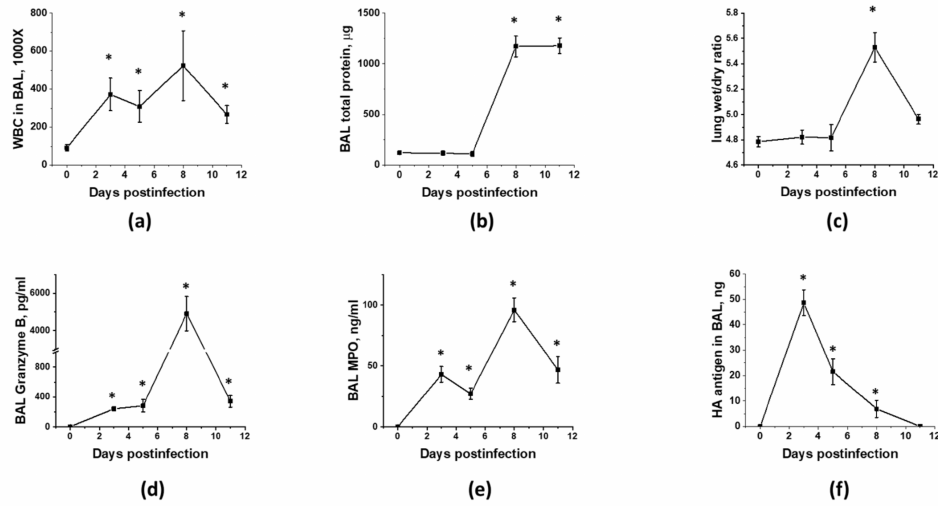
Figure 1. Murine lung infection with IAV is characterized by two distinct phases, a viral clearance phase and a lung injury phase, with white blood cell infiltration during former and latter phases. C57Bl/6 mice received intranasal administration of IAV H1N1 PR8 (800 pfu/mouse) on Day0. Lungs and BAL were collected on the days indicated to analyze for BAL total protein levels ( a ) and white blood cell count ( b ), lung wet/dry ratio ( c ), acellular BAL granzyme B ( d ) and MPO ( e ) levels, and PR8 hemagglutinin level ( f ). n = 4–8 per group, presented are mean +/ − SEM. * for p < 0.05 by t -test with Welch correction (unequal variances) between IAV groups and the control group, receiving saline in lung (plotted as